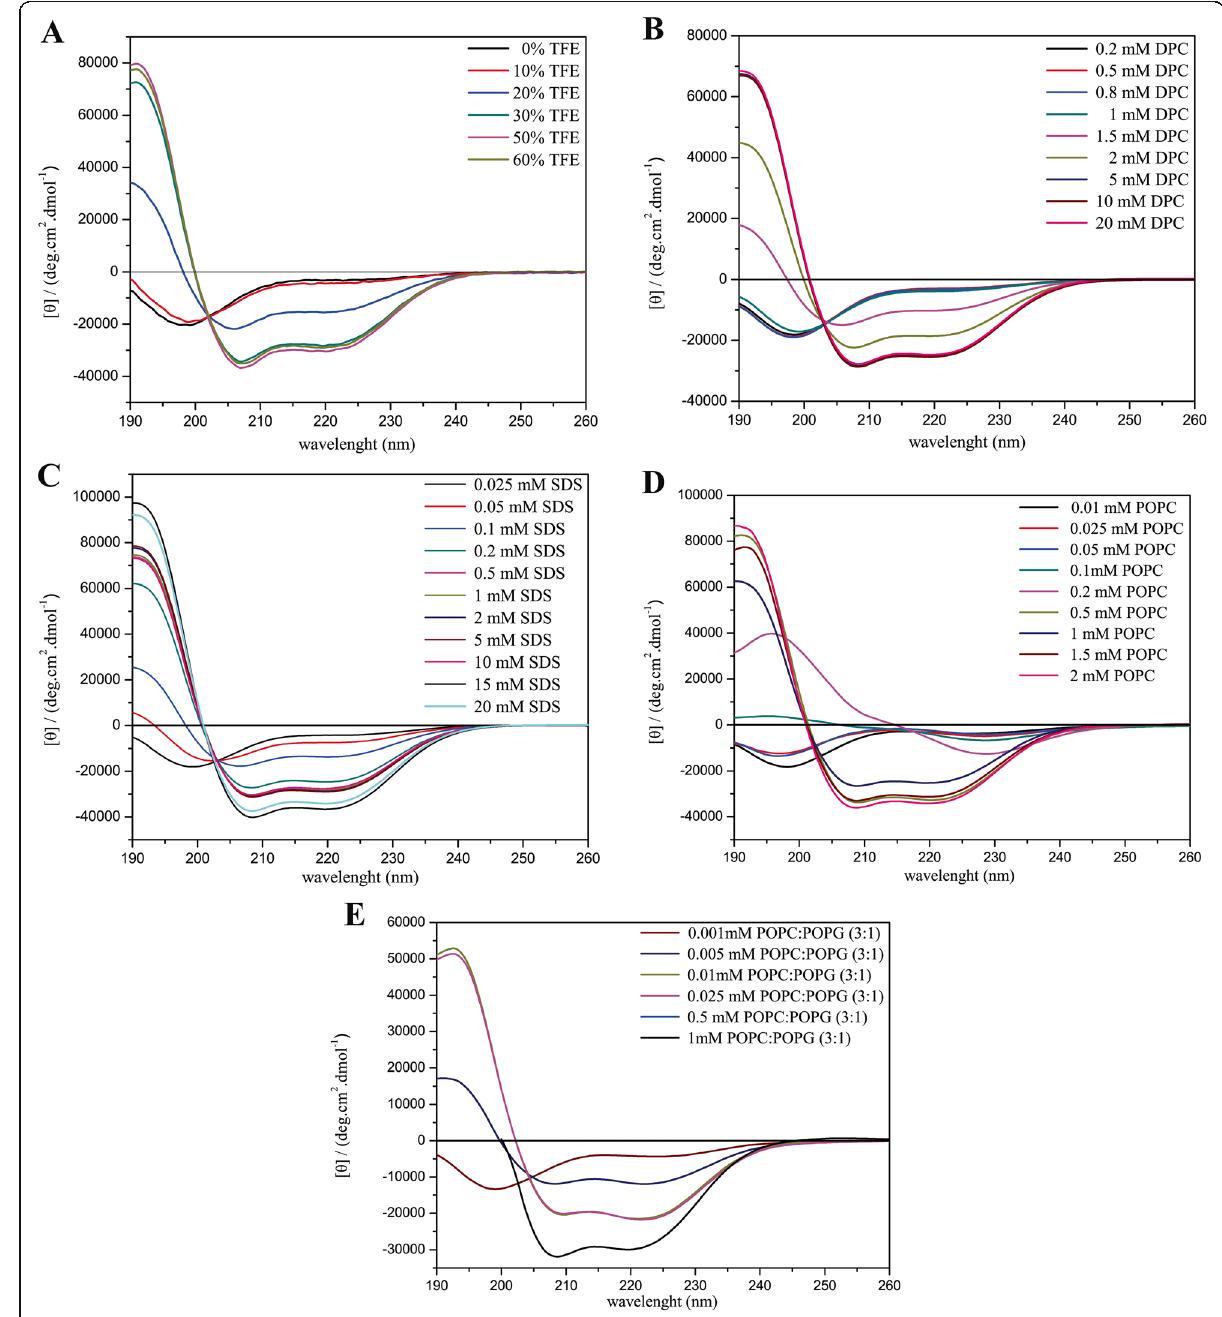
Fig. 6 CD spectra of ocellatin-LB2 in the presence of ( a ) TFE:H 2 O solutions, ( b ) DPC and ( c ) SDS micelles, ( d ) POPC and ( e ) POPC:POPG (3:1)